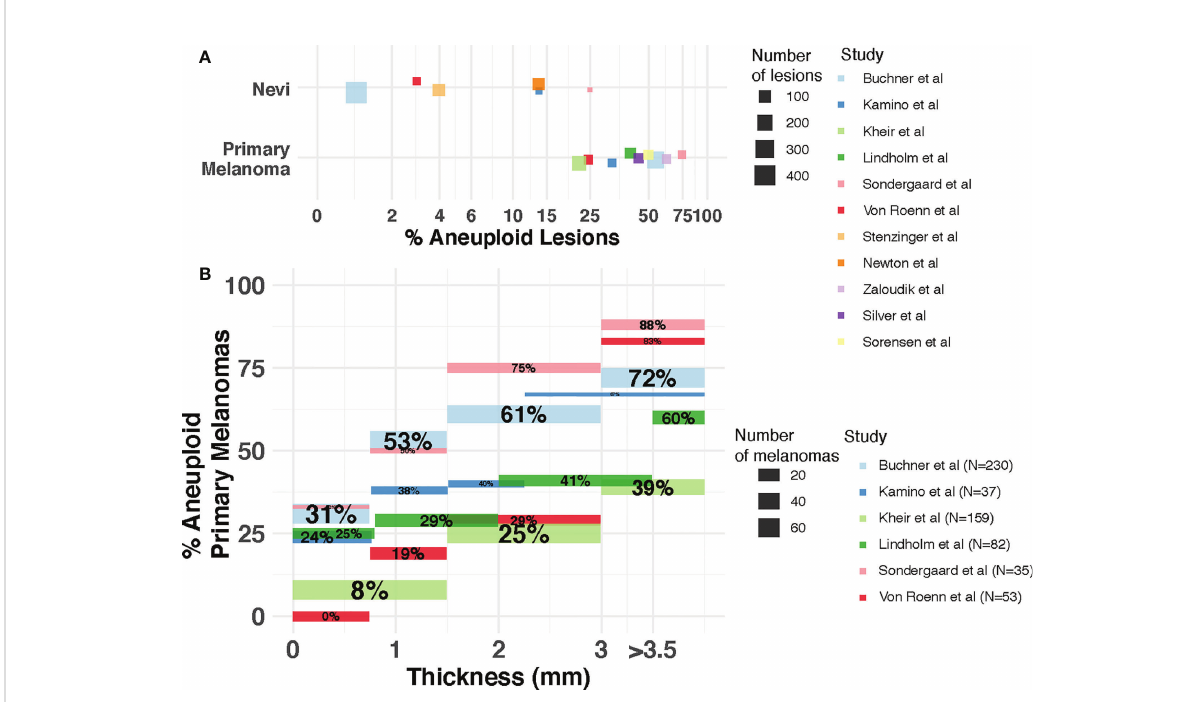
FIGURE 2 Incidence of aneuploidy in cutaneous nevi and melanoma. (A) Aneuploidy in nevi and primary melanomas reported by fl ow cytometry studies. Each dot represents a study. The size of the dot is proportional to the number of lesions (nevi or melanoma) in that study. Position of dots has been jittered vertically for better visualization. (B) Incidence of aneuploidy across thickness. The percentage of aneuploid melanomas reported (y-axis) by each study for each thickness level (x-axis) is represented as a segment. Segment size is proportional to the number of patients in each thickness level for each study. Percentages withing segments indicate the proportion of patients within each thickness level that are aneuploid. Studies included are Kamino et al. (60), Lindholm et al. (61), Buchner et al. (23), Kheir et al. (20), Sondegaard et al. (55), Von Roenn et al. (57), Stenzinger et al. (56), Newton et al. (58), Sorensen et al. (63), Zaloudik et al. (59) and Silver et al.